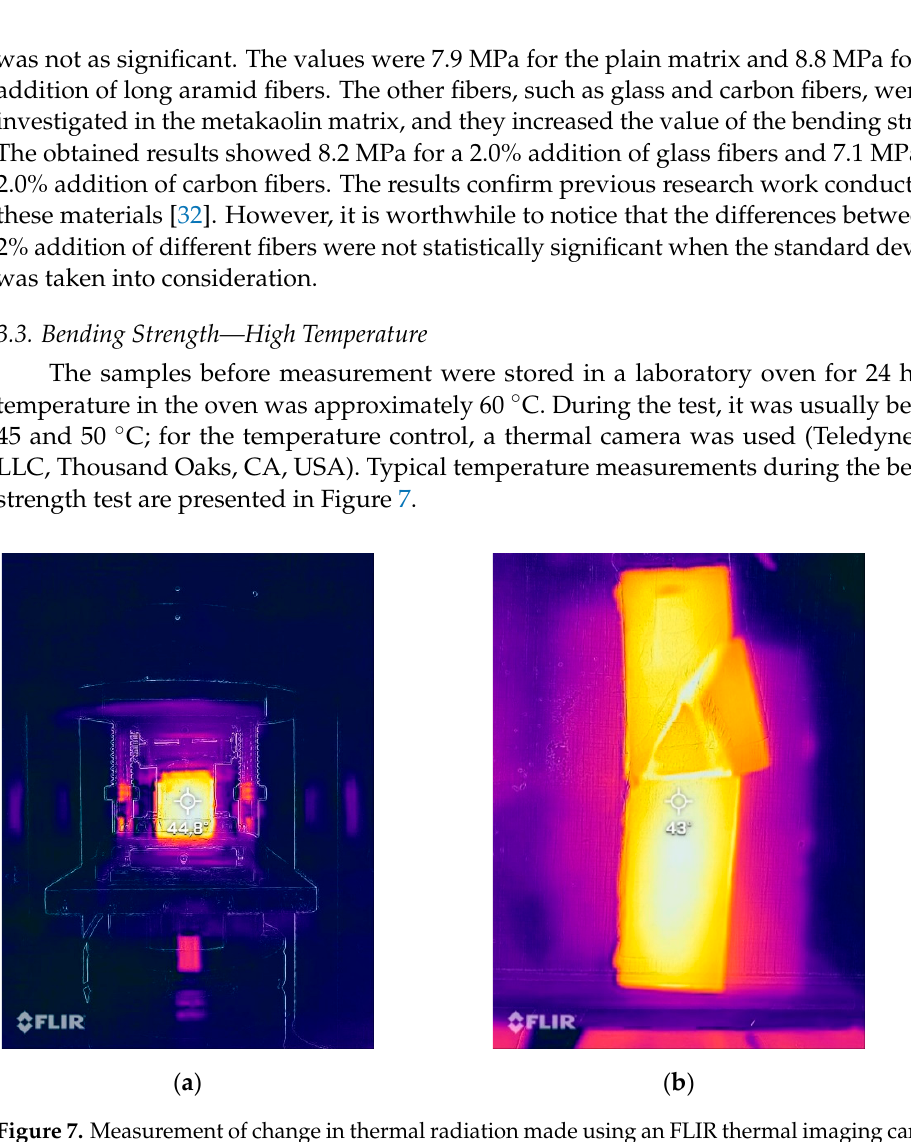
Figure 8. Results of the bending strength test for geopolymer composites at elevated temperature. The overall tendency of material behavior was similar to the results obtained for the ambient temperature. The fiber additions increased the bending strength of the compo- sites compared to the plain matrix. The best values were obtained for the metakaolin- based geopolymer based on metakaolin with 2.0% addition of aramid fibers (13.3 MPa). The lowest value of the bending strength had a plain metakaolin matrix, only 1.5 MPa. The least amount of aramid reinforcement also significantly improved the bending strength. The values were 9.3 MPa and 10.9 MPa for 0.5% and 1% of aramid fiber addition,